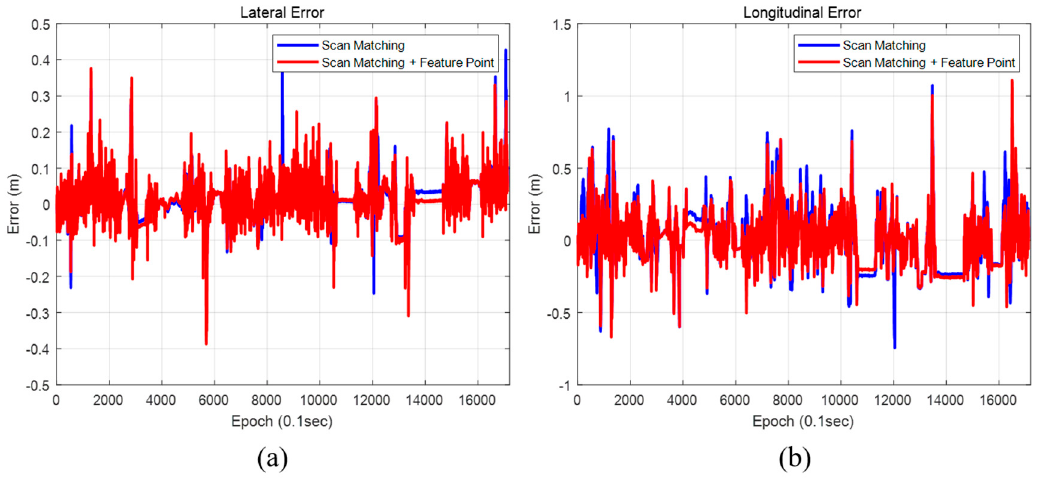
Figure 34. Position error (map matching method). ( a ) Lateral position error, ( b ) Longitudinal position error.